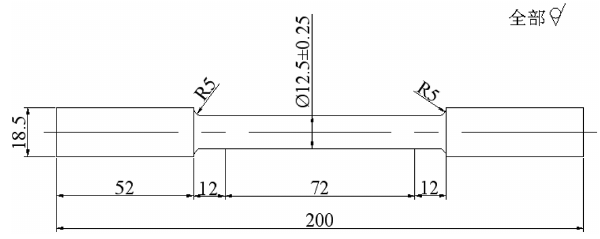
Figure 2: Shape and dimensions of tensile specimens (unit:mm).